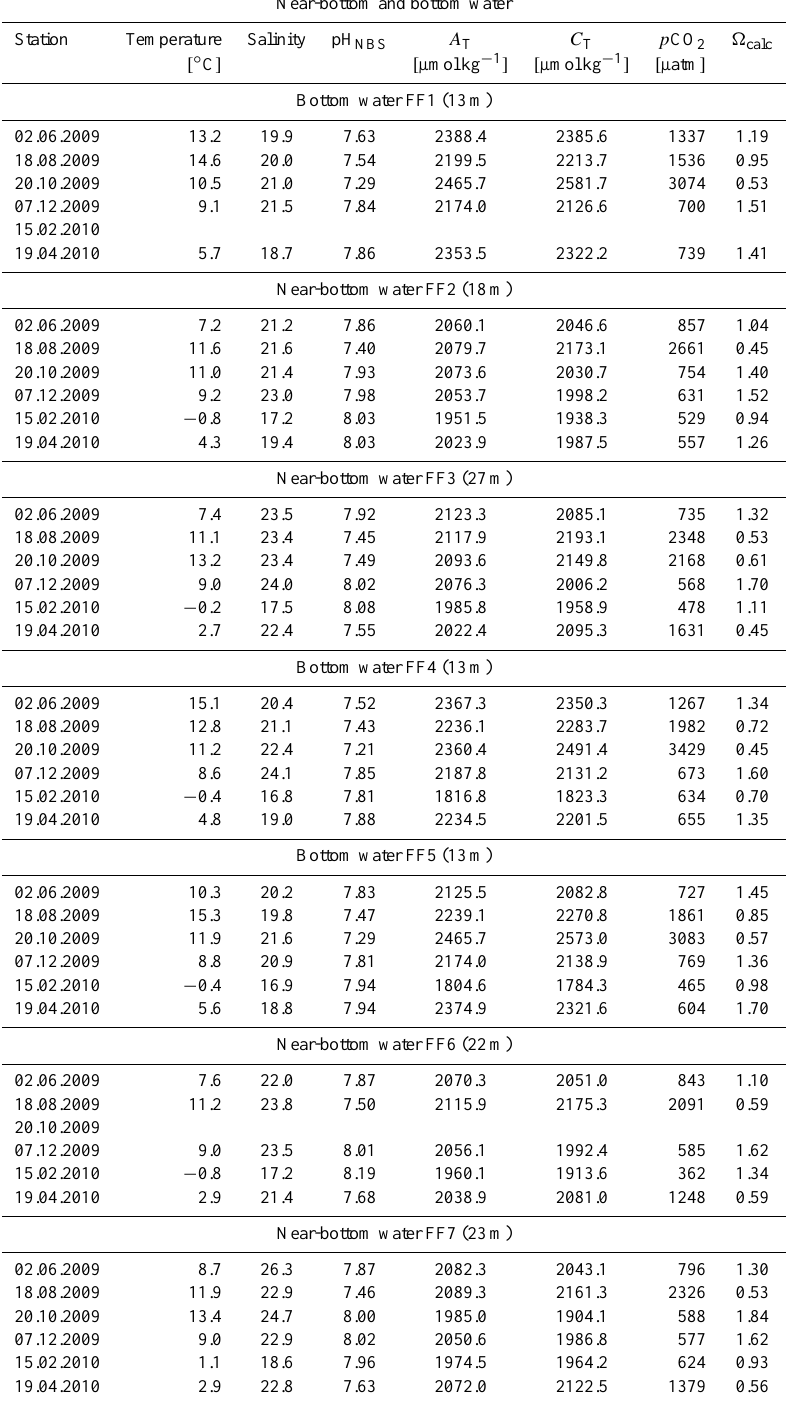
Table 3. Water chemistry parameters of the near-bottom water (1m above the sea floor) at stations FF2, FF3, FF6 and FF7 and of the bottom water (1cm above the sediment surface) at stations FF1, FF4 and FF5 from June 2009 to April 2010. Temperature and salinity were measured by CTD48M probe at all stations from FF1 to FF7. At stations FF1, FF4 and FF5, the bottom water pH NBS were measured using a WTW 340i. Analysis of total alkalinity ( A T ) was determined with a Metrohm titration instrument. Dissolved inorganic carbon ( C T ), carbon dioxide partial pressure ( p CO 2 ) , and omega calcite ( (cid:127) calc ) were calculated using the CO2Sys-program. At stations FF2, FF3, FF6 and FF7, analyses for total alkalinity ( A T ) and dissolved inorganic carbon ( C T ) were measured by coulometric and potentiometric titration using SOMMA and VINDTA systems. pH NBS , carbon dioxide partial pressure ( p CO 2 ) and omega of calcite ( (cid:127) calc ) were calculated using the